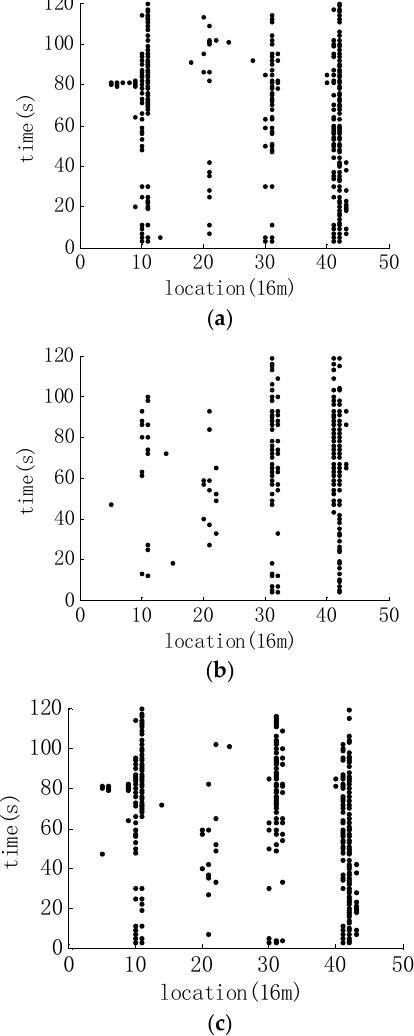
Figure 20. The detection results of picking signals. ( a ) The first group of picking signals; ( b ) The second group of picking signals; ( c ) The third group of picking signals.